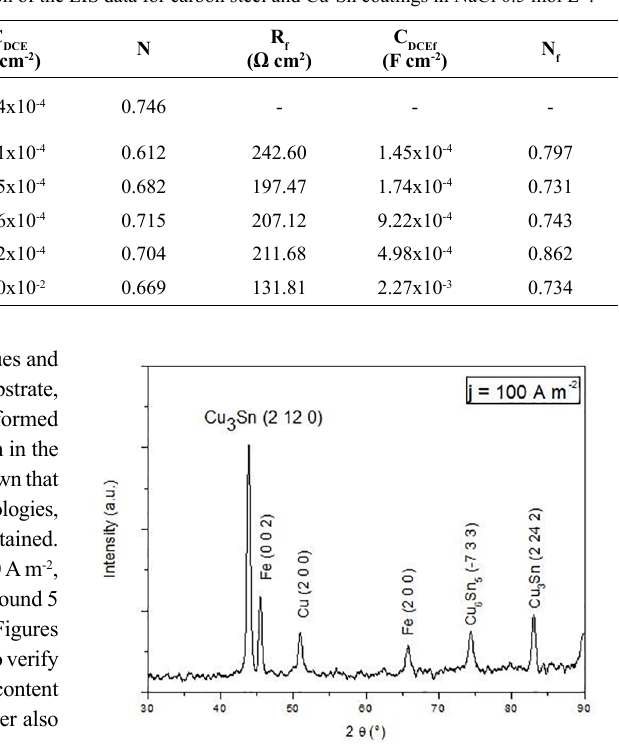
database (Materials Data JADE 5 XRD pattern